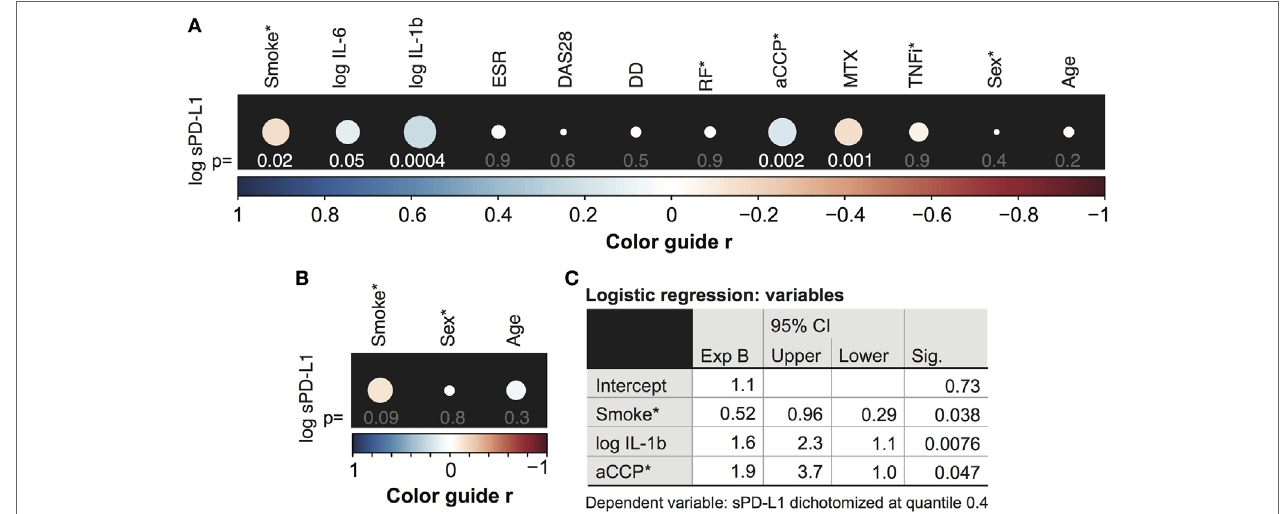
FigUre 1 | Serum levels of soluble PD-L1 (sPD-L1) are low in smokers. (a,B) Spearman correlation between the logarithm of sPD-L1 and interleukins (IL)-6 and IL-1 β , disease activity score (DAS28), erythrocyte sedimentation rate (ESR), disease duration (DD), anti-cyclic citrullinated peptide (aCCP) and rheumatoid factor (RF), weekly dose of methotrexate (MTX), anti-tumor necrosis factor α antibody (TNFi) treatment (a) , and age and sex (a,B) . sPD-L1 was measured in 246 RA patients (a) and 168 healthy controls (B) . The color guide shows the value of r . (c) Results of the logistic regression analysis. sPD-L1 was dichotomized into groups with low levels (0) and high levels (1). The variables indicated with (*) are nominal or ordinal and only take on values 1 and 0. Smokers, aCCP + , RF + , and TNF-inhibiting antibodies treated and males are assigned number